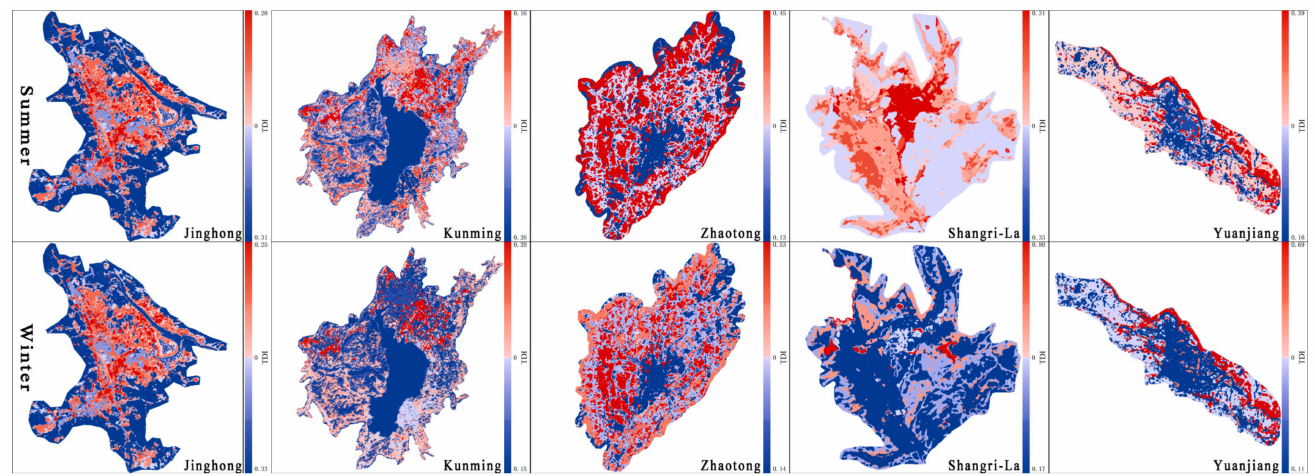
Figure A2. The TDI distributions in five cities (the red color represents LCZs with heating effects, and the blue color represents LCZs with cooling